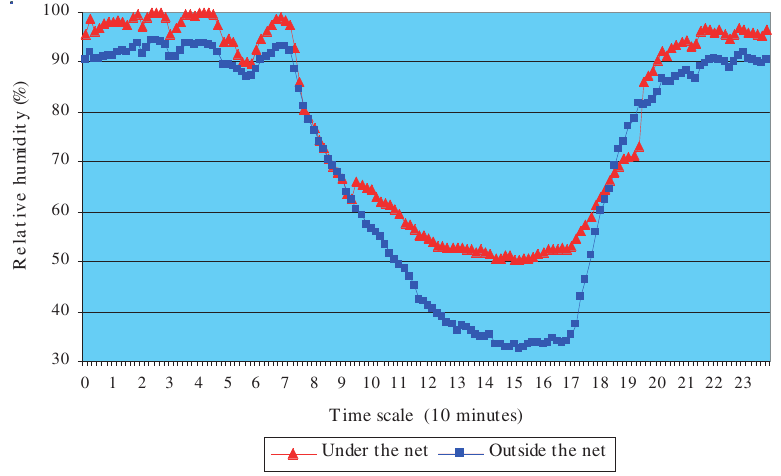
Figure 5 . The mean daily course of the relative air humidity measured under the hail net and outside of it on a particularly day with high variation of air humidity (RN June 1 – September 30./